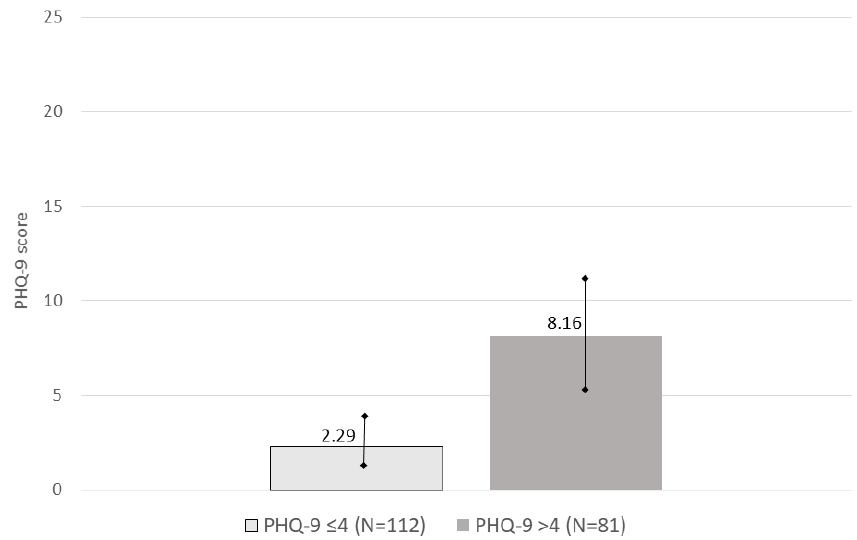
Figure 1. PHQ-9 scores. Groups subdivided according to the 4 cut-off. Bars represent standard de- viation.